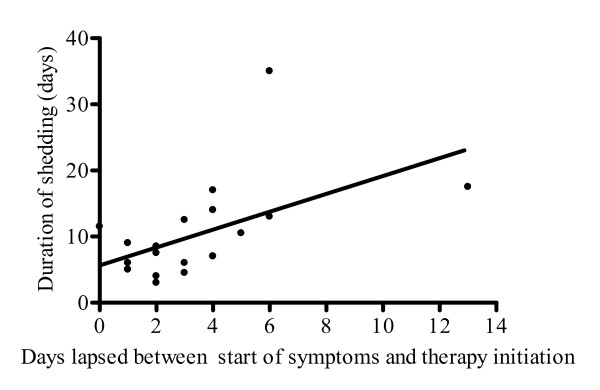
Correlation of duration of viral shedding with interval between symptom onset and therapy start. The analysis was performed on data from 20 patients treated with inhibitors of NA, who reached undetectable PCR during the observation period (r = 0.531, p = 0.016).